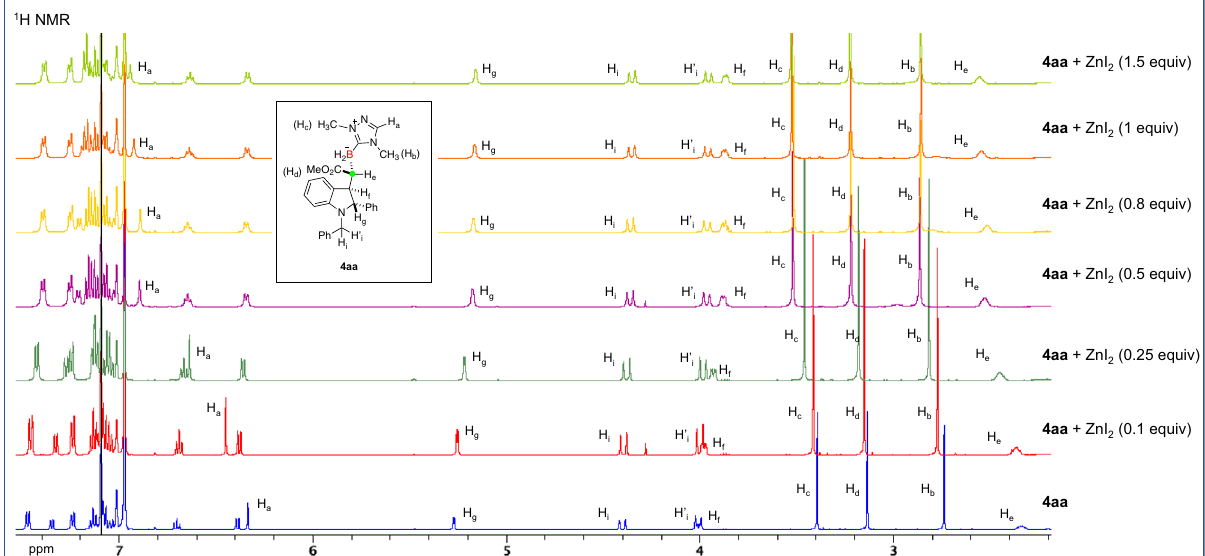
Fig. 5 Analysis of the diastereoselectivity in the NHC-BH 3 2b/thiol E-controlled HAT process. a Competing HAT pathways of Int-III-A . b NCI plots of TS-A-major and TS-A-minor .